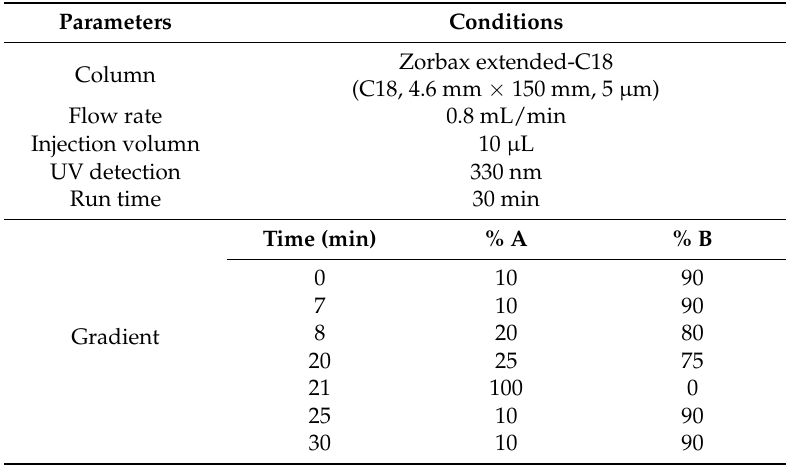
Table 6. Analytical conditions of HPLC system for analyzing two